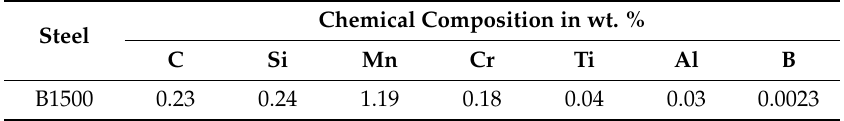
Table 1. Chemical composition in wt. % of B1500 steel.